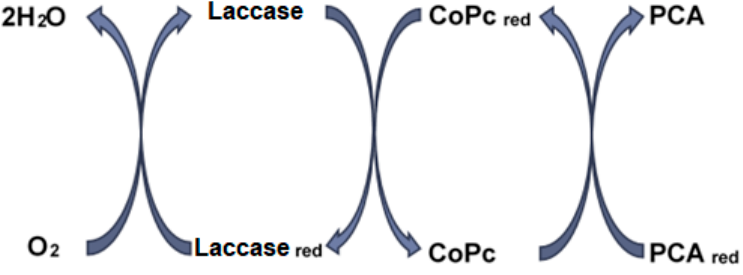
Figure 6. Scheme of p-coumaric redox process, adapted from [67,68].